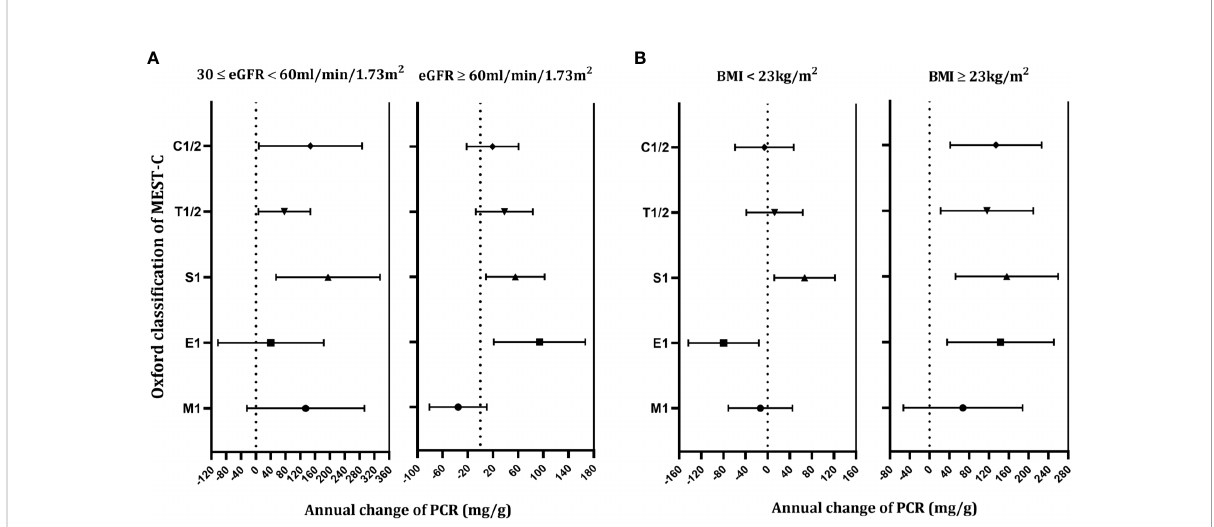
FIGURE 4 Correlation between the Oxford Classi fi cation MEST-C score and the annual changes in proteinuria/creatinine ratio in immunoglobulin A nephropathy patients with estimated glomerular fi ltration rate ≥ 30, <60, and ≥ 60 ml/min/1.73m 2 (A) , body mass index <23 and ≥ 23kg/m 2 (B) , respectively. Estimates were made from mixed-effect models adjusted for age, gender, MEST-C score, mean arterial pressure, estimated glomerular fi ltration rate, body mass index and treatments. Estimates (95% con fi dence interval) are shown in mg/g per year for each Oxford Classi fi cation score.